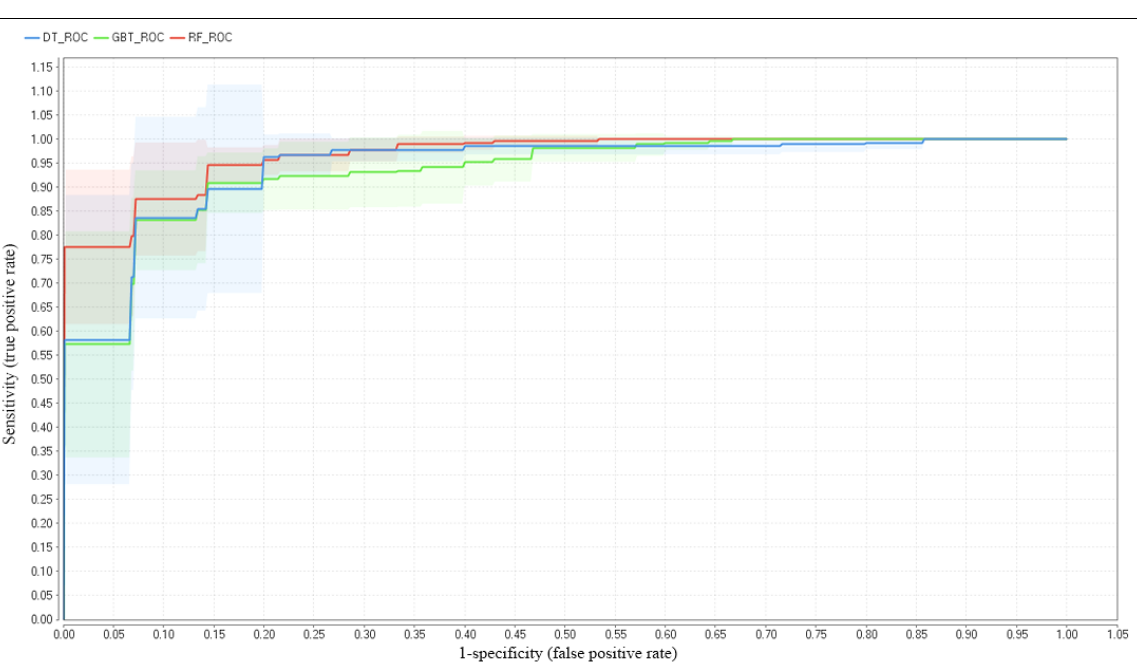
Figure 5. Suicide ROCs curves of decision tree (blue line), gradient boosting trees (green line), and random forest (red line) using six important trauma items and four important suicide